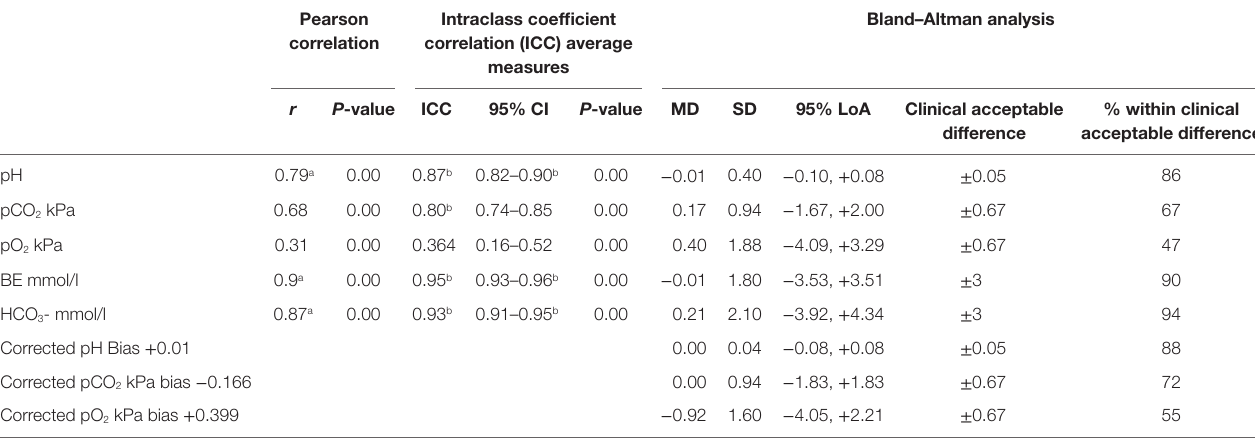
TaBle 2 | The Pearson correlation, intraclass coefficient, and Bland–Altman analysis, including limits of agreement (LoA) of the different components of capillary blood gas and venous blood gas. Pearson